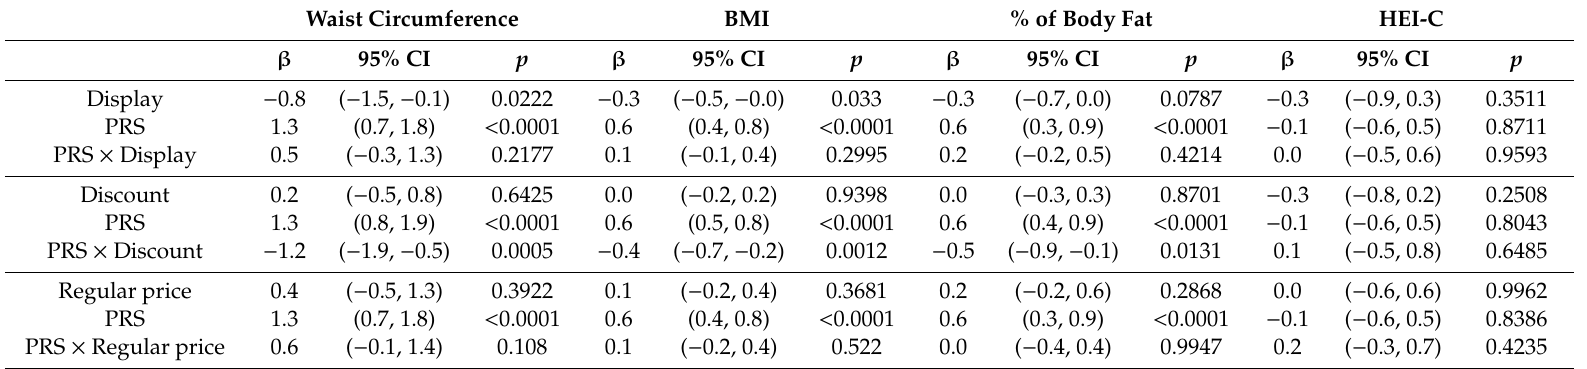
Table 7. Main and interaction e ff ects of PRS and retail food environment scores on adiposity-related outcomes among males ( n =